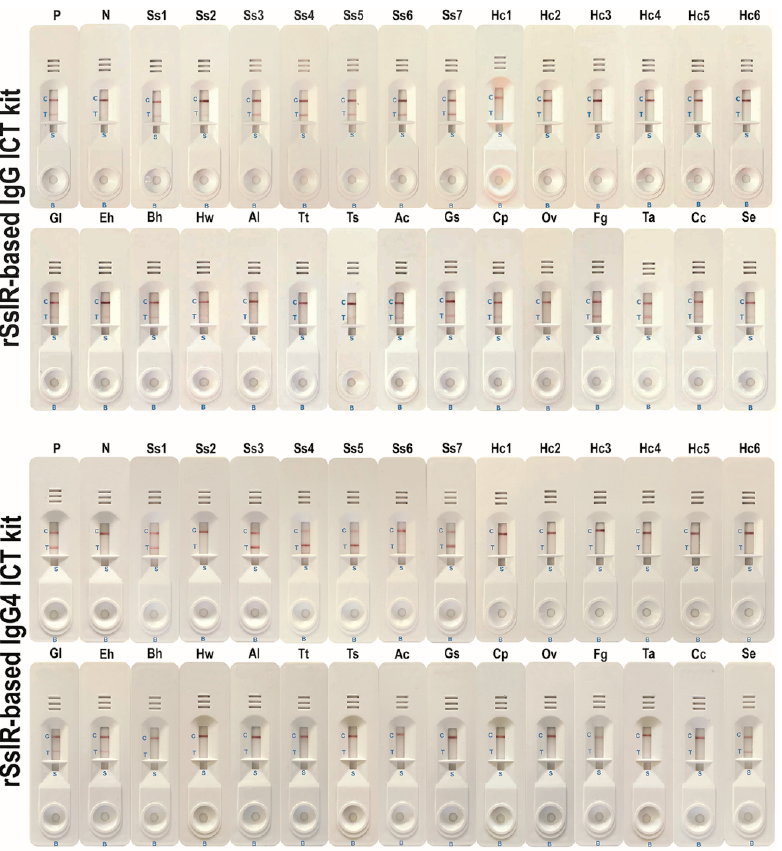
Figure 2. Representative results of the rSsIR-based IgG ICT kit and the rSsIR-based IgG4 ICT kit. P, positive pooled serum samples; N, negative pooled serum samples; Ss1–Ss7, strongyloidiasis; Hc1–Hc6, healthy serum; Gl, giardiasis; Eh, amoebiasis; Bh, blastocystosis; Hw, hookworm infections; Al, ascariasis; Tt, trichuriasis; Ts, trichinellosis; Ac, angiostrongyliasis; Gs, gnathostomiasis; Cp,